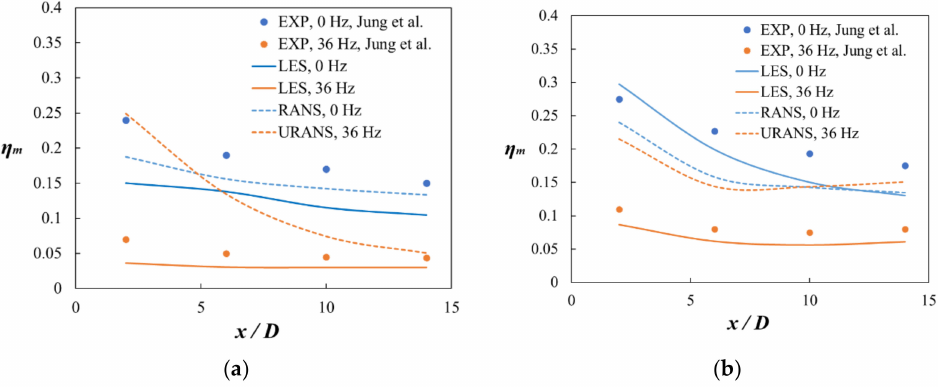
Figure 5. Time-and spanwise-averaged effectiveness at 0 and 36 Hz as a function of x/D . ( a ) Simple angle ( β = 0 ◦ ); ( b ) Compound angle ( β = 30 ◦